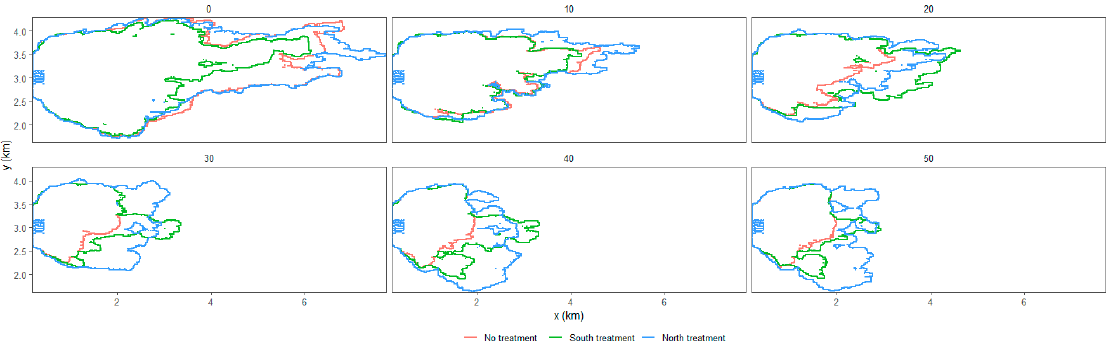
Figure 5. Footprints of fire areas after 7.5 h of fire spread for all treatment scenarios, after each decade of simulated forest growth.